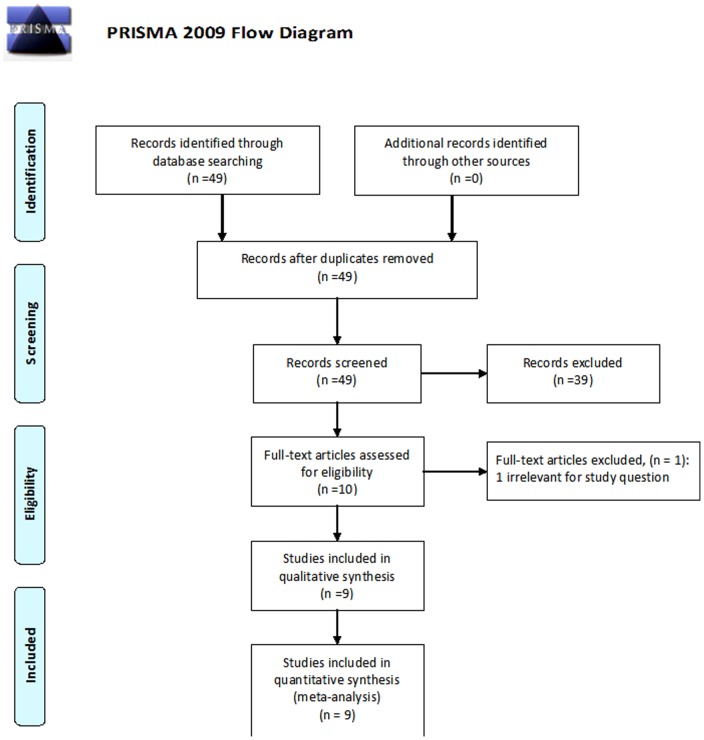
PRISMA flow diagram.